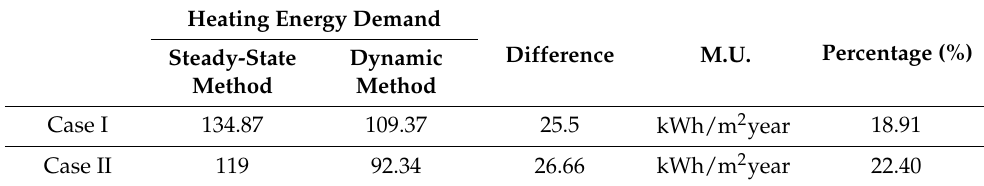
Table 7. Final results for the heating energy